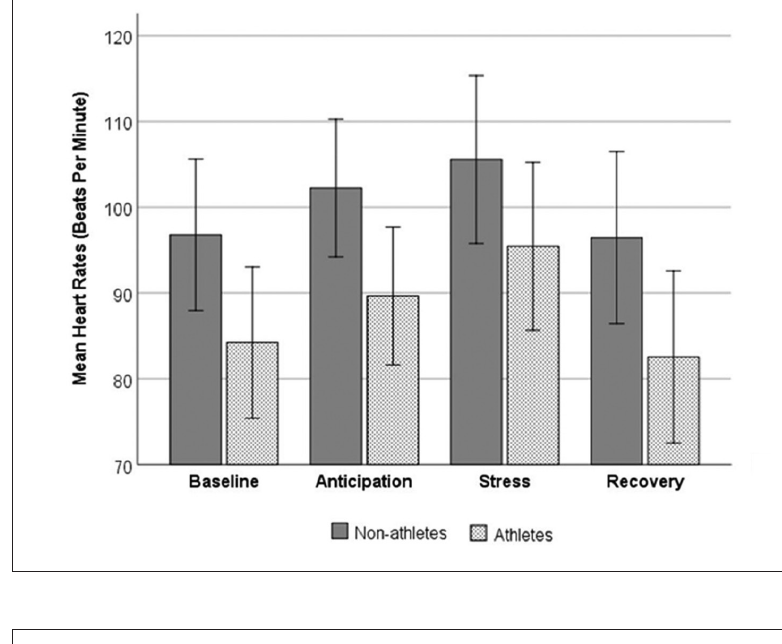
Figure 3. Relative (to baseline) changes in heart rate in three phases of stress exposure